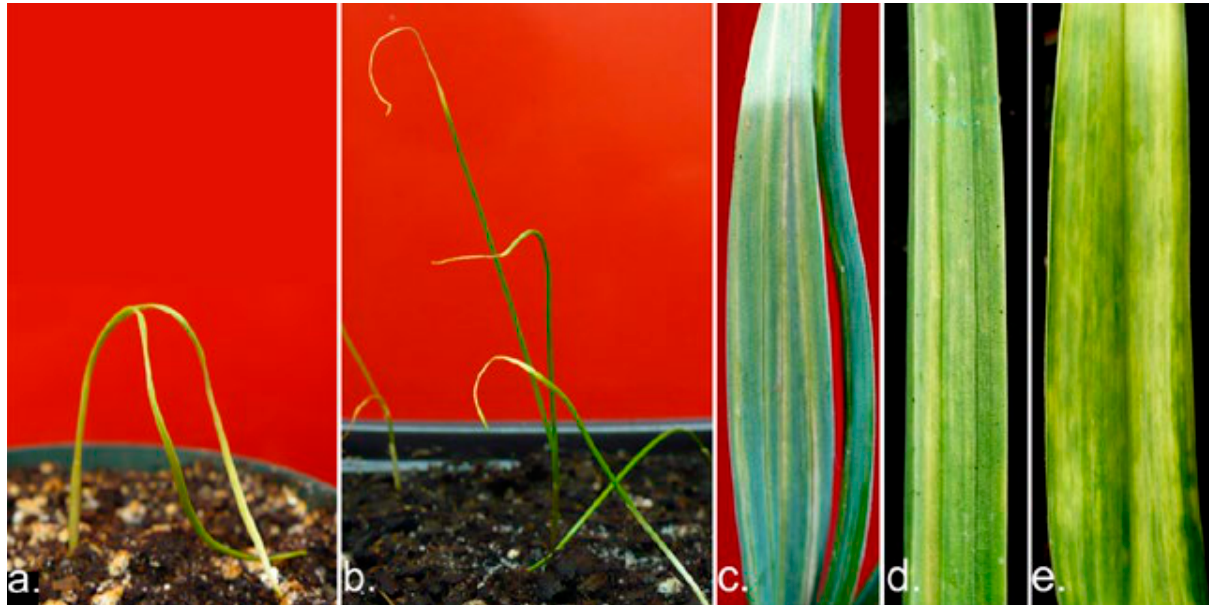
Figure 1. a, ‘Bianco Piacentino’, and b, ‘Rosso di Sulmona’ Italian varieties grown from bulbils, expressing yellowing and inhibited growth. c, yellow stripes observed in plants growing from bulbs originating from California (non-organic). d, yel- low streaks in plants growing from bulbs originating from China, Argentina, and California (organic). e, yellow mottling observed in plants growing from bulbs originating from California